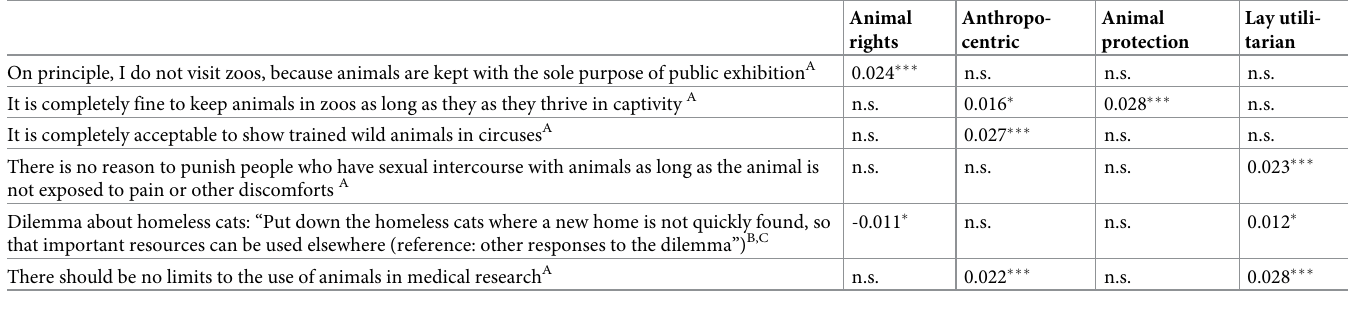
Table 2. Tests of association between the animal ethics dimensions and opinions about the human use of animals (N =